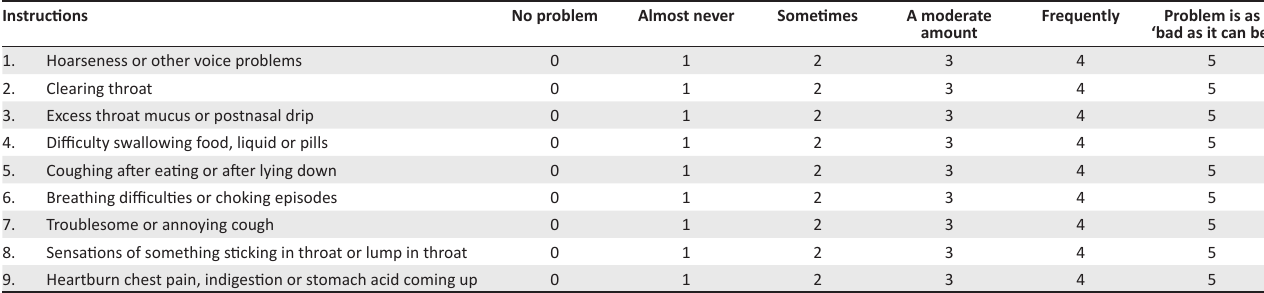
TABLE 1: Reflux symptom